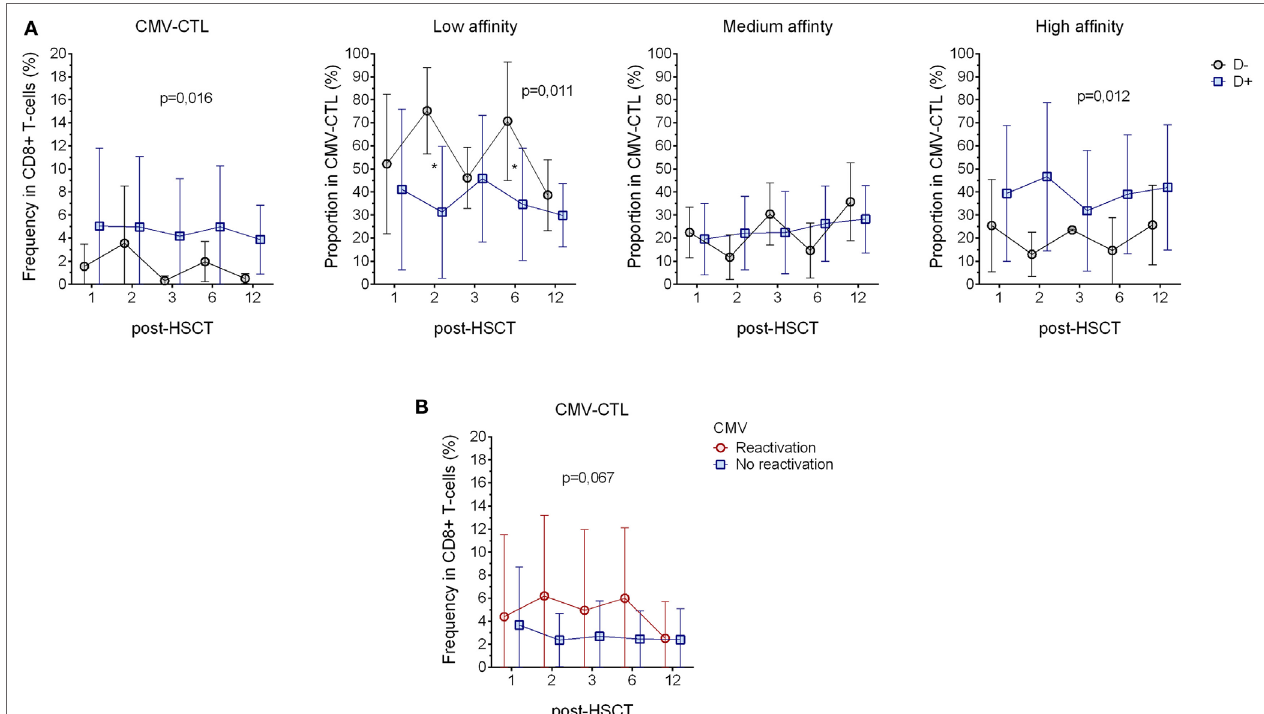
FigUre 3 | Correlation with the donor serostatus and cytomegalovirus (CMV) reactivation. (a) Comparison of CMV-CTL frequency, low-, medium-, and high-affinity proportion between patients with donor presenting different CMV-serological status (D + : blue square and D − : black circle) (b) Analysis of CMV-CTL in between patients diagnosed with CMV reactivation (red circle) and patients who did not present sign of reactivation (blue square). Mean and SD are represented. Two-way ANOVA was used to detect differences between two groups over time. * p <